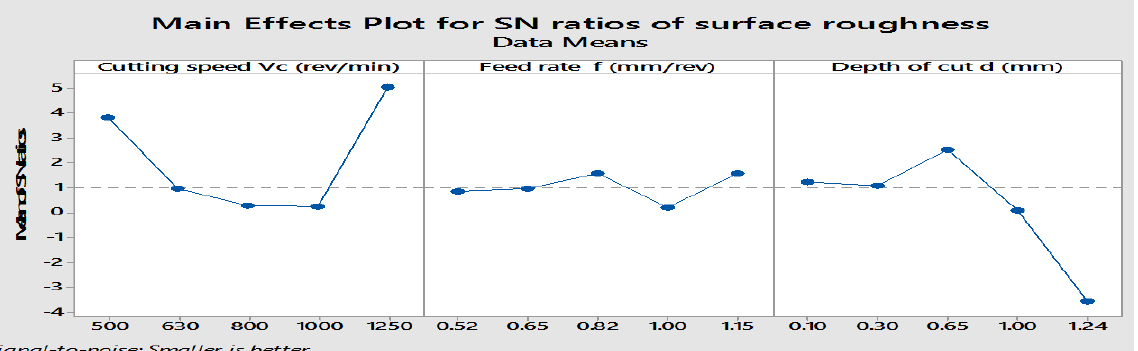
Figure 6: Main effect plot of S/N ratio for surface roughness using JBCF